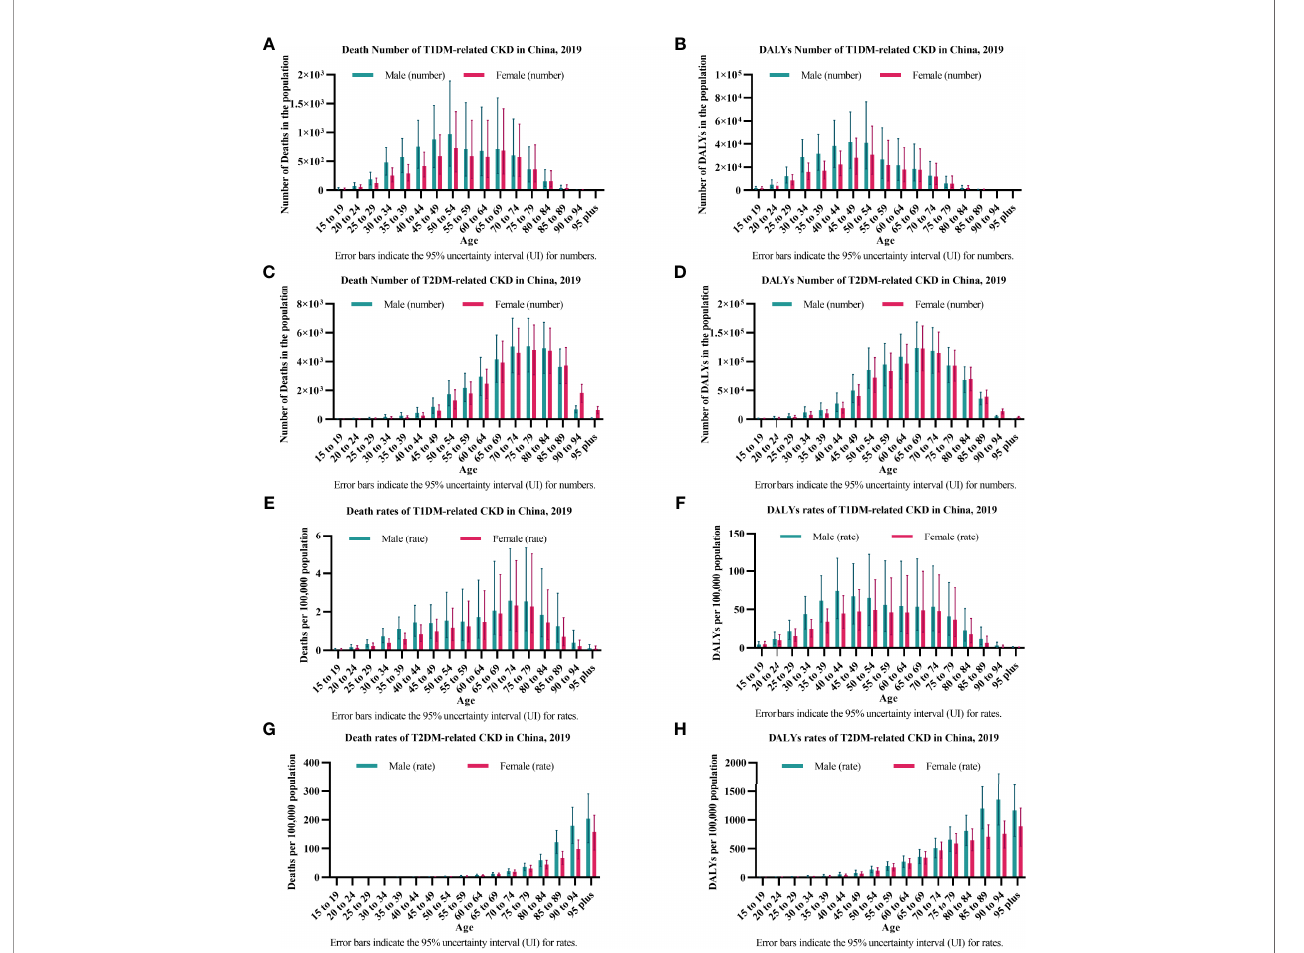
FIGURE 2 | The burden of diabetes-related CKD by age in 2019. (A, B) show the numbers of deaths and DALYs of T1DM-related CKD. (A) Deaths; (B) DALYs; (C, D) show the numbers of deaths and DALYs of T2DM-related CKD. (C) Deaths; (D) DALYs; (E, F) show the crude rates of deaths and DALYs of T1DM-related CKD. (E) Deaths; (F) DALYs; (G, H) shows the crude rates of deaths and DALYs of T2DM-related CKD. (G) Deaths; (H) DALYs; CKD, chronic kidney disease; T1DM, type 1 diabetes mellitus; T2DM, type 2 diabetes mellitus; DALYs, disability-adjusted